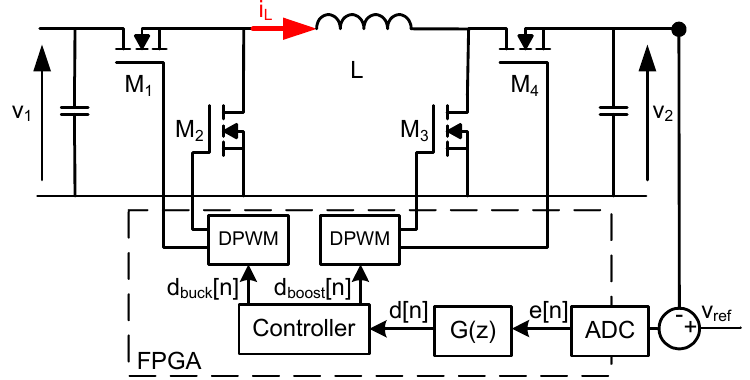
Figure 1. Diagram of a digitally-controlled 4SBB.